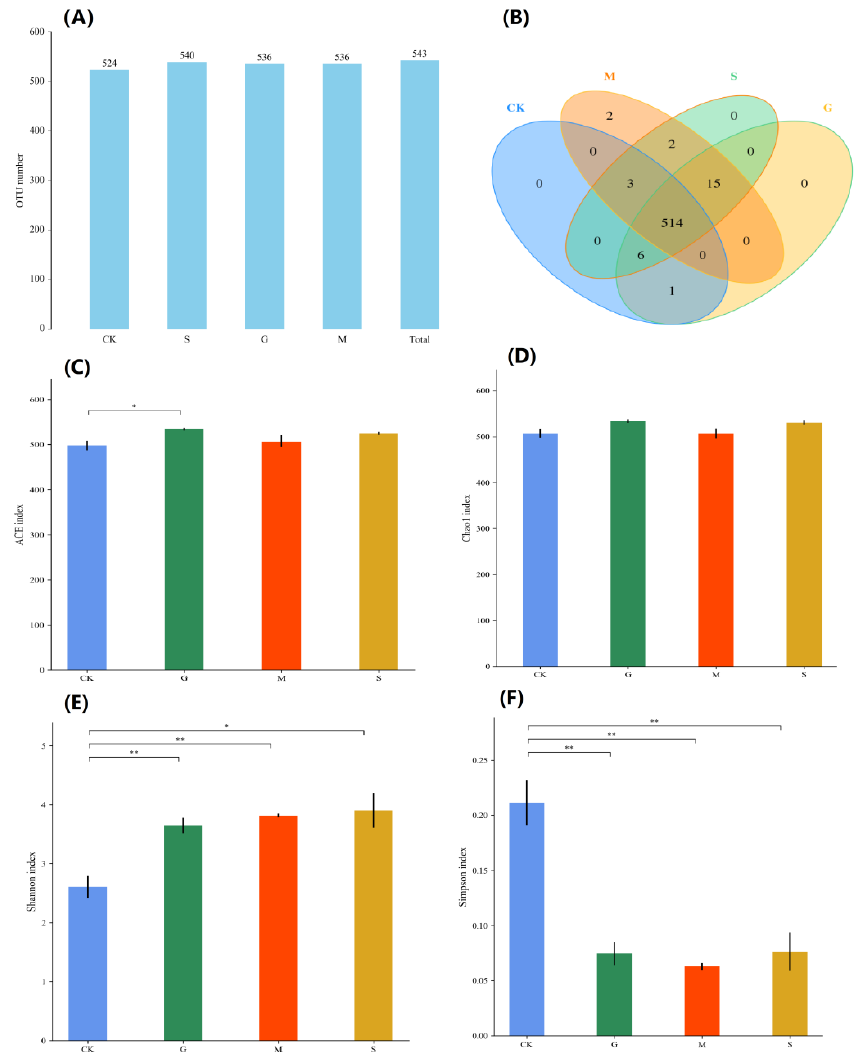
Figure 1. Venn analysis of OTUs and alpha-diversity of the bacterial community of stylo silage. ‘*’ and ‘**’ represent p < 0.05 and p < 0.01, respectively. CK, control; S, sucrose; G, glucose; M, molasses.( A ) OTUs number of the bacterial community of stylo silage; ( B ) Venn analysis of OTUs in the bacterial community of stylo silage; ( C – F ) the ACE, Chao1, Shannon and Simpson index of the bacterial community of stylo silage, respectively.